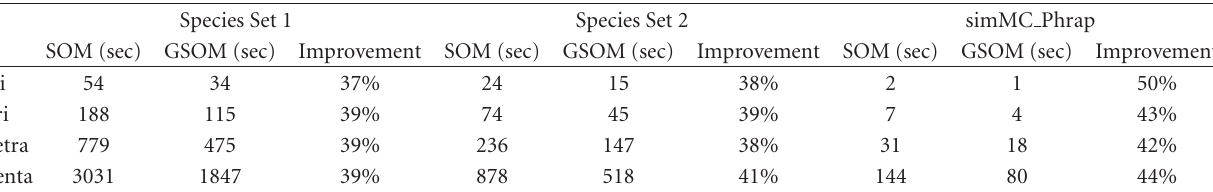
Table 6: Speed comparisons for the first two training phases of SOM and GSOM, in which the improvement columns represent the per- centage of speed improvement for GSOM comparing to SOM.